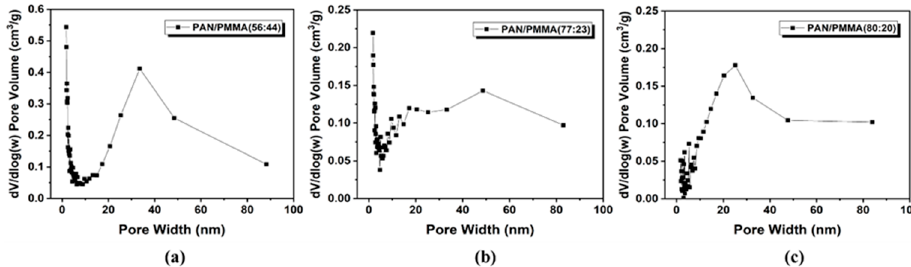
Figure 5. BJH analysis of nitrogen physisorption showing the pore volume distribution with ceramic pressure load: ( a ) 0 N; ( b ) 0.62 N; ( c ) 1.12 N; ( d ) 1.28 N. Table 1. Textural properties of obtained carbon nanofiber materials.